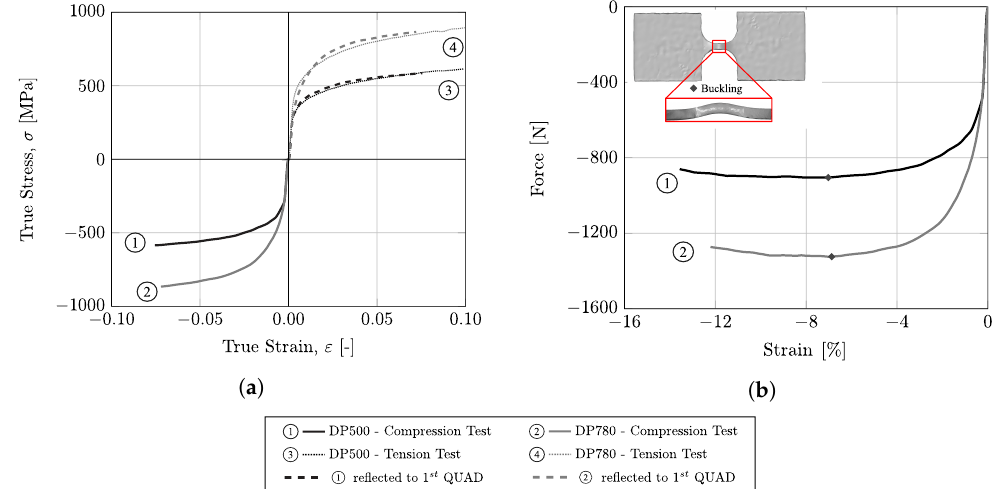
Figure 8. True stress–strain curves from monotonic compression tests and comparison with tension tests; ( b ) buckling point at the compression test.